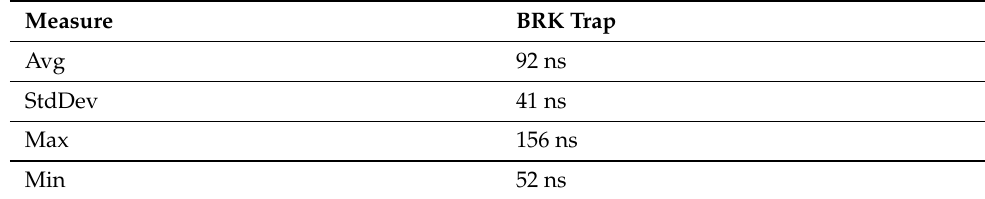
Table 2. Transition latency.